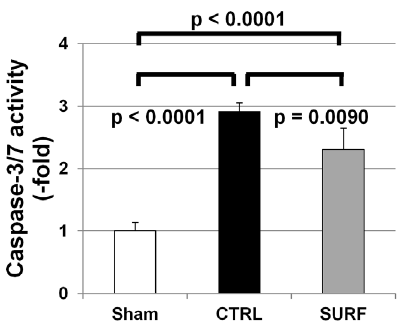
Figure 4. Caspase Activation Assay. All values are expressed as the mean 6 SD.